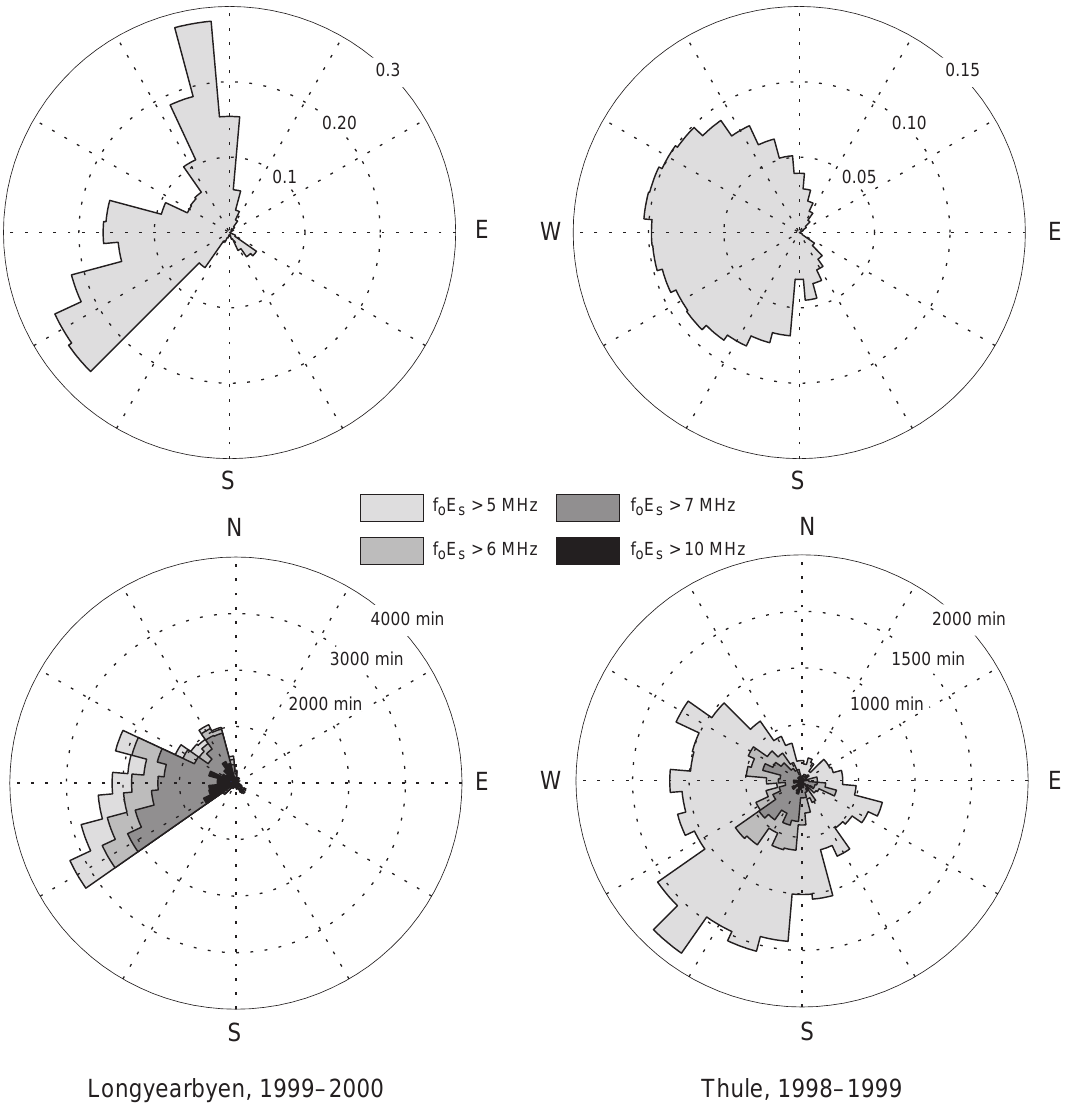
Fig. 8. Top panels: The angular distribution of the unnormalised total probability of sporadic-E occurrence (product of the field and growth probabilities in Fig. 7) at Longyearbyen (left)and at Thule (right). Bottom panels: Distributions of observed Es occurrence at Longyearbyen and at Thule as a function of the electric field direction, calculated from the observed IMF using the APL model. Separate distributions are plotted for layers with peak plasma frequencies higher than 5, 6, 7 and